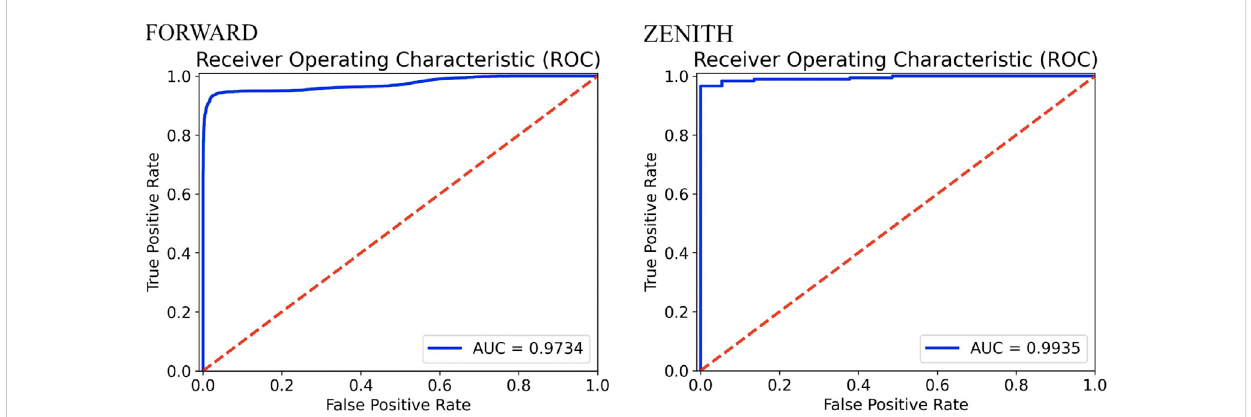
FIGURE 4 CDNNROCcurves.ROCcurvesfortheforwardCDNNandzenithCDNNmodels.TheforwardCDNNistestedagainst setK ,andthezenithCDNNis tested against setV . The (blue) curve demonstrates the rate at which our CDNN classi fi es clouds better than a random binary classi fi cation. The (red) dottedlinerepresentsabaselinerandombinaryclassi fi cationforclouddetection,wheretheclassi fi cationrepresentsarandomassignmentastowhether a cloud is present or not. “ Area under the curve ” (AUC) represents the total accuracy of the CDNN in accounting for all true positive and negative classi fi